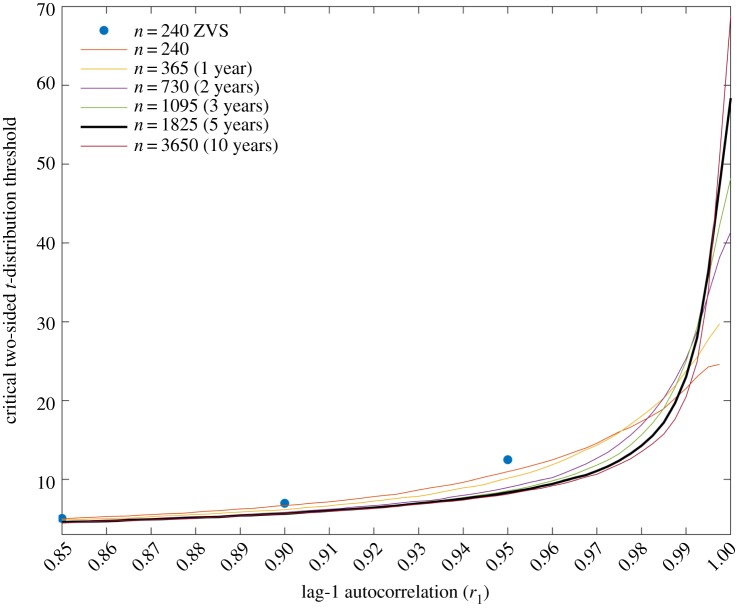
Critical t-statistics at the high end of the r1 scale for the 80% two-sided confidence interval generated using the method described in the appendix. Change in the statistic with increasing sample sizes is indicated for the maximum sample size explored by Zwiers and von Storch (ZVS) in [39], n = 240, out to the equivalent of a 10-year series of daily thickness samples from sea ice models, n = 3650 (no-leap calendar). Tabulated values from Zwiers & von Storch [39] appear as blue data points and are comparable with the n = 240 red trace generated using the large ensemble method used in this paper. The statistic for the baseline series length used by the CICE Consortium, n = 1825, appears in bold black.